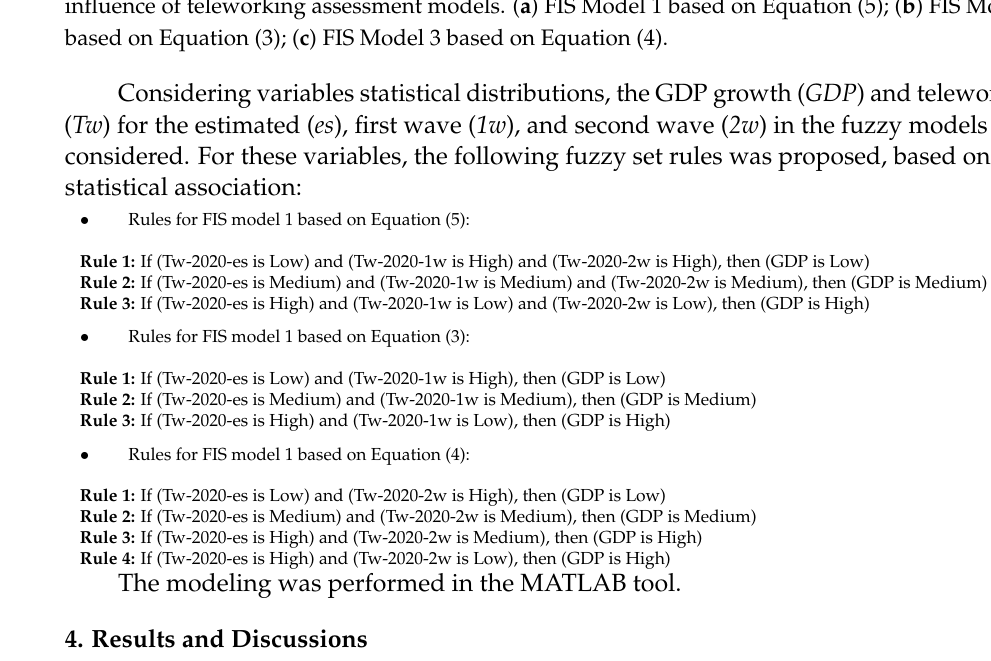
Table 2. Summary statistics for the interest